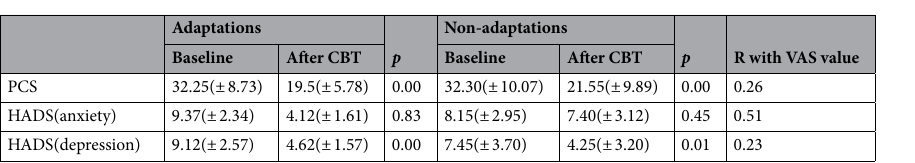
Table 7. Average defference in HADS and PCS before/after the CBT intervetion and R with VAS value.